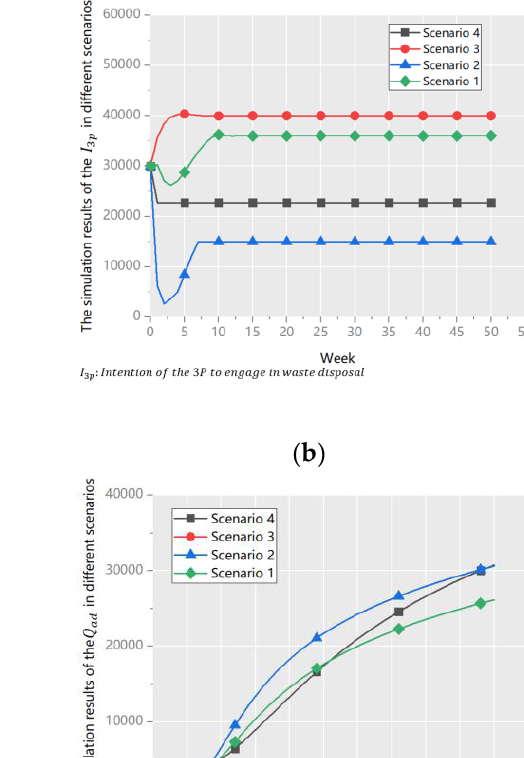
bb ; ( b ) I 3p ; ( c ) Q cd ; ( d ) Q ad